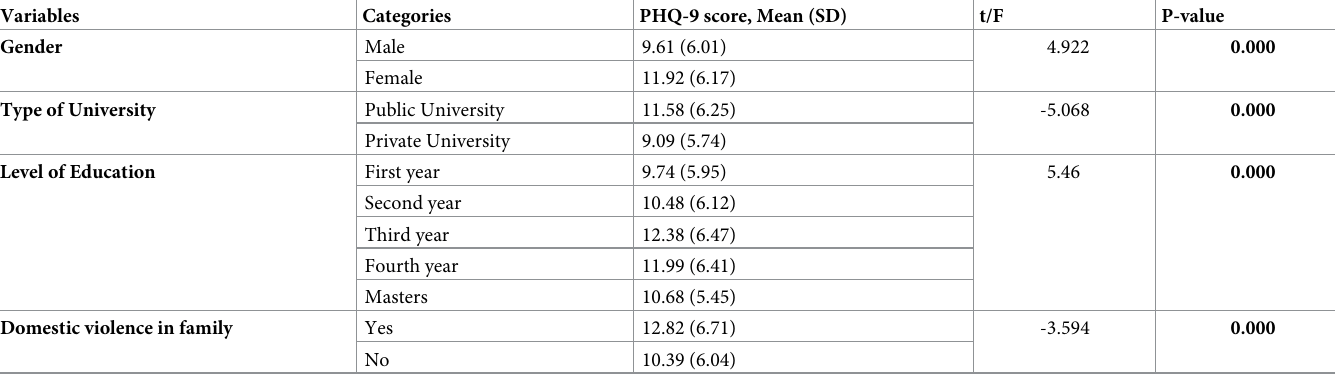
Table 4. Association of PHQ-9 score with socio-demographic characteristics (N = 677).